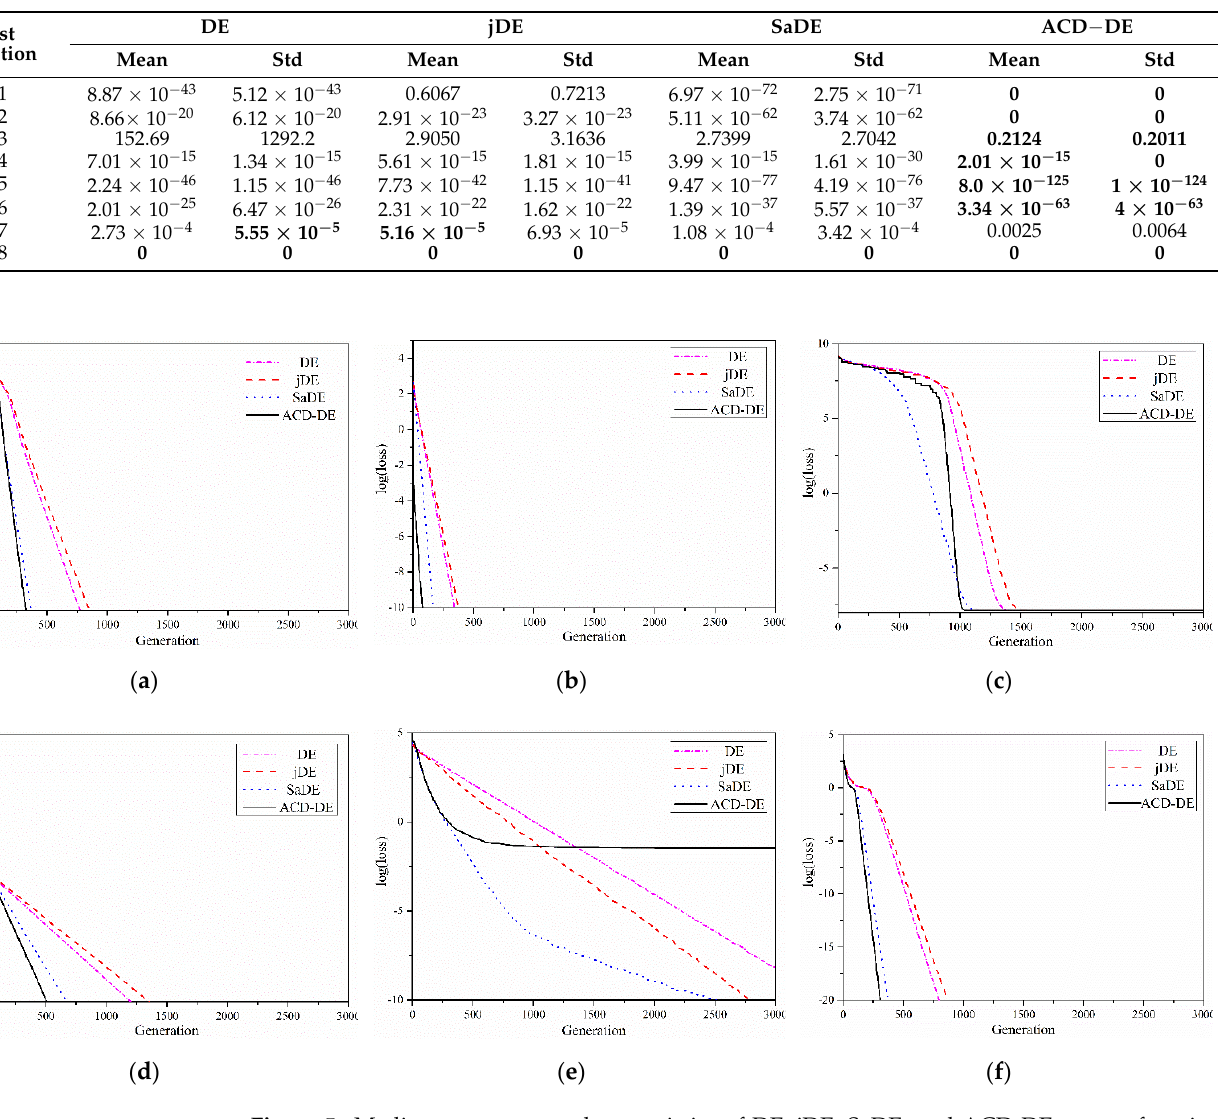
Table 6. Comparison results of four optimization algorithms.